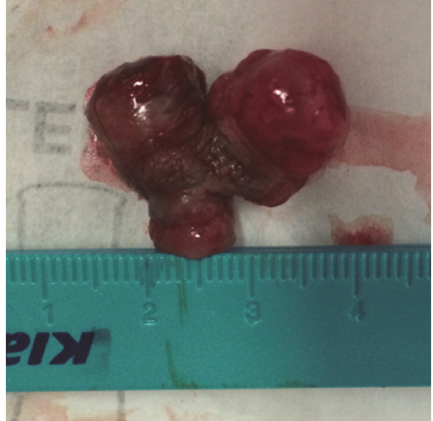
Figure 2: Vulvar lobular capillary hemangioma after excision: specimen sent to histopathological examination.